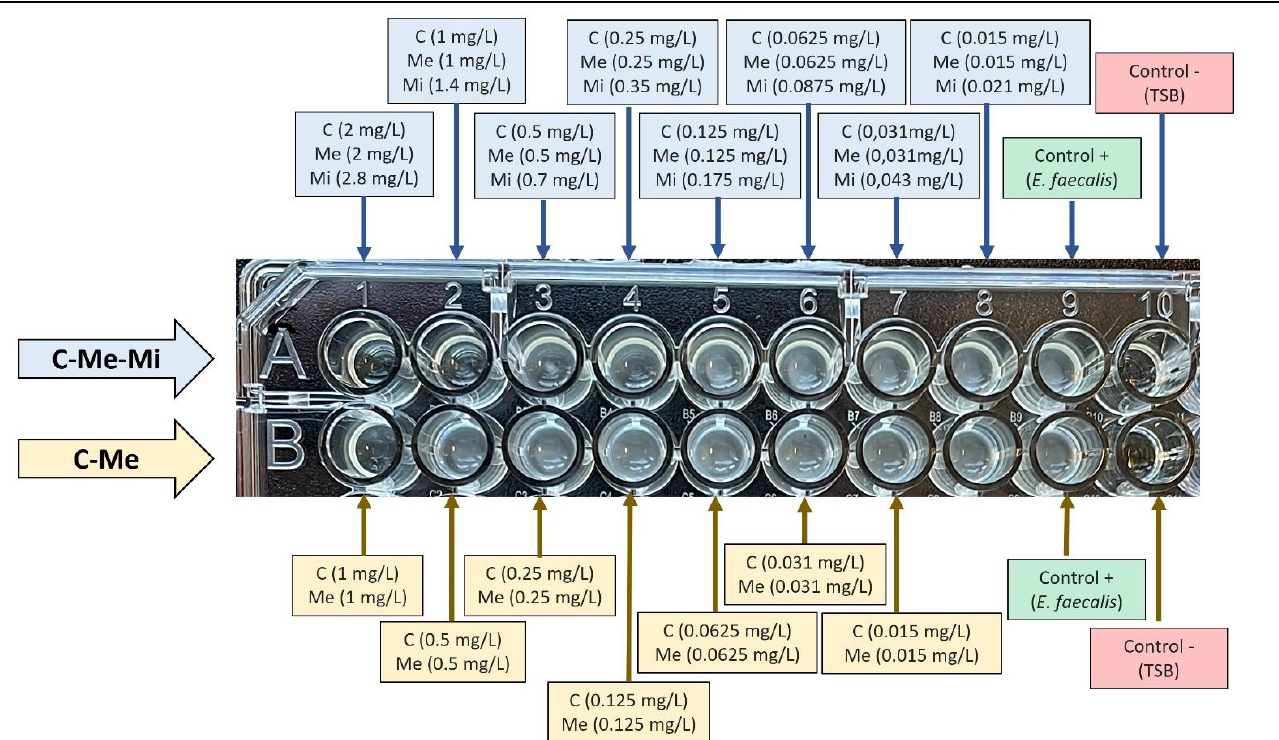
Figure 3. MIC determination of different antibiotic concentrations against E. faecalis ; C (ciprofloxacin), Me (metronidazole), and Mi (minocycline); mg/L (milligrams per liter); TSB (Trypticase Soy Broth).